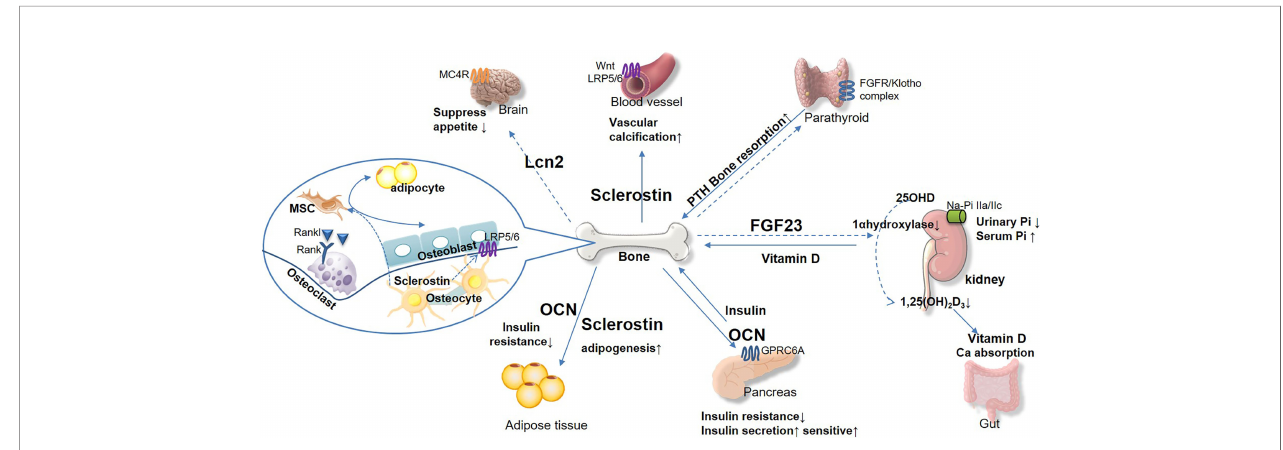
FIGURE 1 | The emerging role of bone-derived hormones in glucose metabolism and cross-talk in kidney, pancreas, and other diabetic complication target organs. Bone acts as the endocrine organand links kidney and glucose metabolism. Bone-derived hormone FGF23 is secreted from osteocytes and regulates urinary phosphorus excretion from kidney. FGF23 suppresses 1 a -hydroxylase activity, inhibits 1,25(OH)2D3, and reduces parathyroid hormone (PTH) level. Osteocalcin (OCN) acts on pancreas and adipose tissue to regulate glucose and energy metabolism, insulin secretion, and insulin resistance. Sclerostin plays important role in vascular calci fi cation, which promotes chronic kidney disease progression directly and indirectly. Osteoblast secreted lipocalin-2 (LCN2) regulates central food intake and pancreatic b -cell proliferation, to maintain glucose and energy homeostasis. The bone-derived hormones would be potential therapeutic target for DM and complications based on their effect on maintaining glucose homeostasis and bone